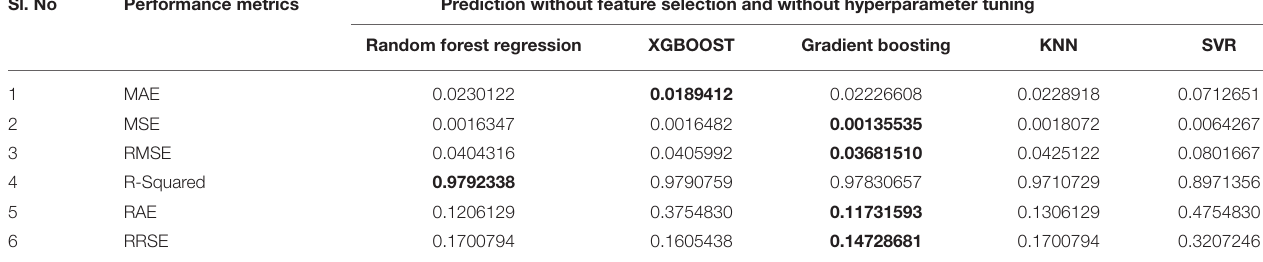
TABLE 2 | Prediction without Feature Selection and without hyperparameter tuning. Sl.